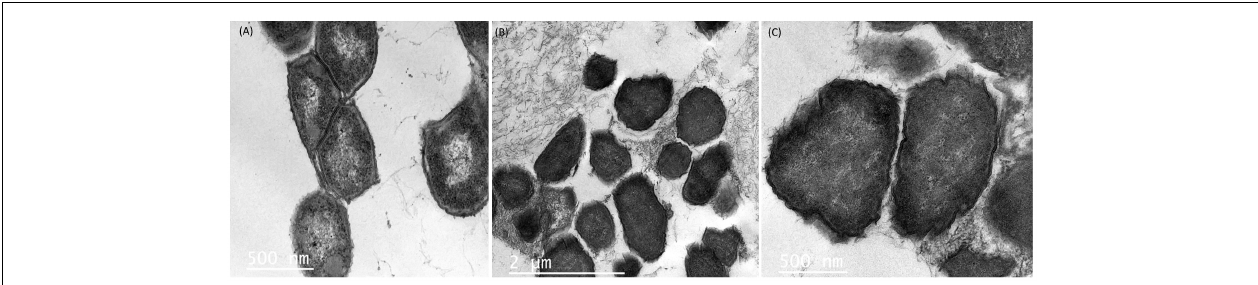
FIGURE 6 | Transmission electronic microscopy images of S. enterica subsp. enterica ATCC51741. (A) Untreated bacteria. (B,C) Bacteria treated with PC from UTNGt21A at 1 × MIC for 6 h. Scale bars correspond to 500 nm and 1 µ m.